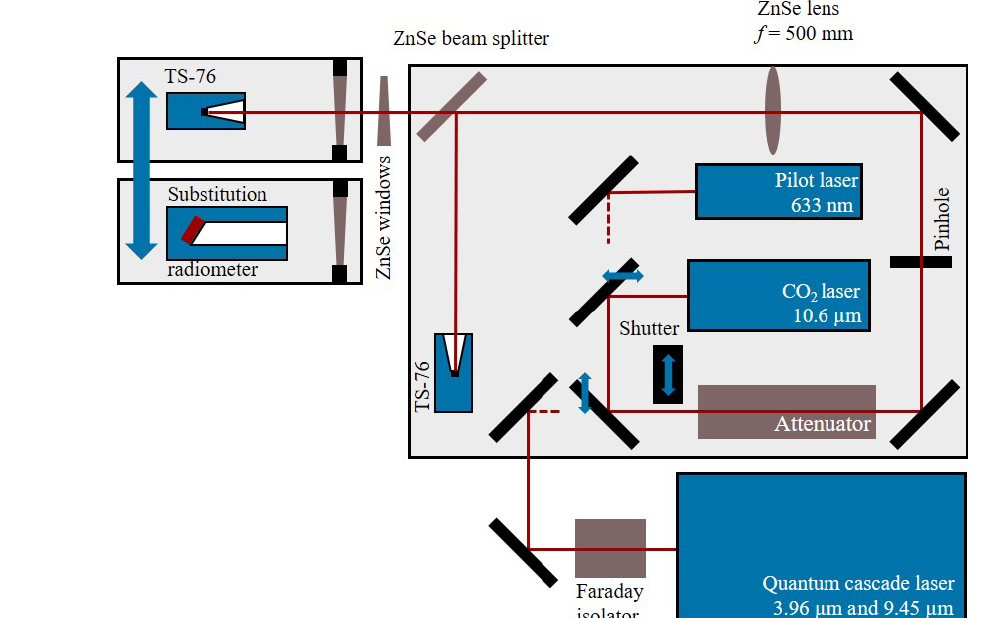
Figure 3. Optical path at the cryogenic electrical substitution radiometer facility for calibrations in the MIR.